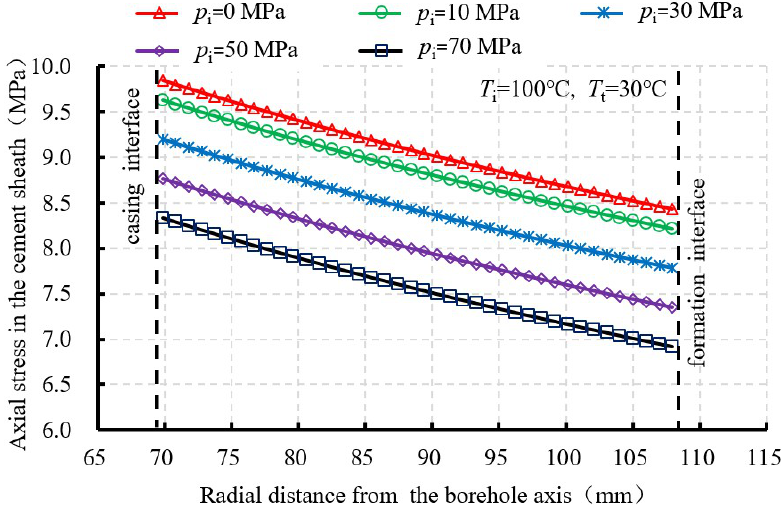
Figure 9. Radial distribution of the axial stress in the cement sheath under different increased casing pressures p i and a decreased temperature of 70 °C at the casing inner wall.